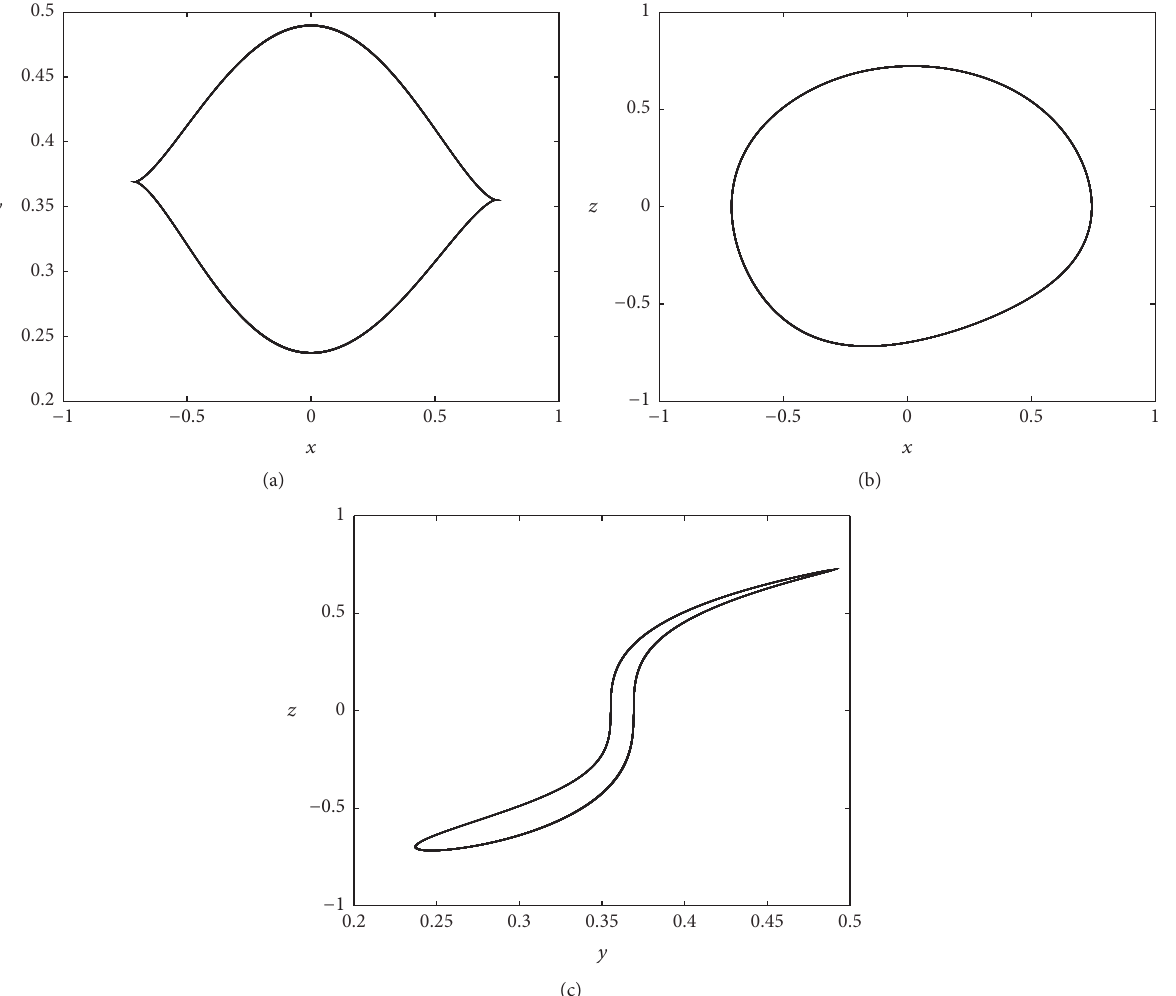
Figure 4: Limit cycle of the system with infinite equilibria (1) in (a) 𝑥 - 𝑦 plane, (b) 𝑥 - 𝑧 plane, and (c) 𝑦 - 𝑧 plane for 𝑎 = 3.35